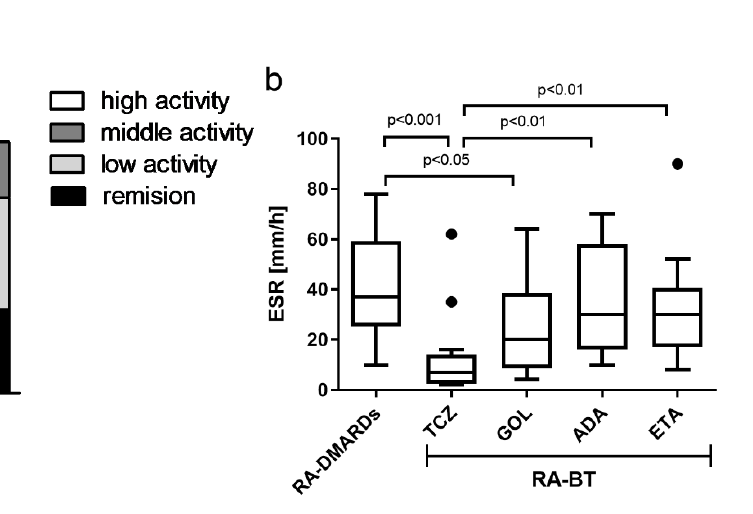
Figure 5: DAS, ESR and CRP parameters of tested subjects. a ) The proportion of disease activity score (DAS28) indicating remission, low- middle- and high-ac- tivity of disease and RA patients undergoing a standard RA therapy (RA-DMARDs) or different types of biologi- cal treatment (RA-BT). The levels of erythrocyte sedi- mentation rate and C-reactive protein (CRP) in RA pa- tients without BT (RA-DMARDs), and the effects of treat- ment with BT (RA-BT). Differences in values of erythro- cyte sedimentation rate (ESR; b ) and C-reactive protein (CRP; c ) were compared for patients with RA without BT (RA-DMARDs; n = 20), and RA patients receiving dis- tinct BT (RA-BT) - tocilizumab (TCZ, n = 20); golimumab (GOL, n = 20); adalimumab (ADA, n = 20); or etanercept (ETA, n = 19). Data are presented as box plots display- ing the median, mean (+), 25 th and 75 th percentiles, min- imum and maximum (whiskers), and outliers’ values (●). The statistical difference was determined by unpaired two-tailed Student's t-test. The difference with p<0.05 was considered